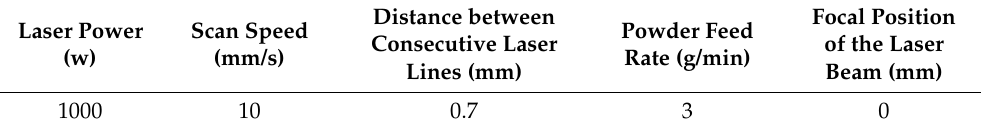
Table 4. Fabrication control